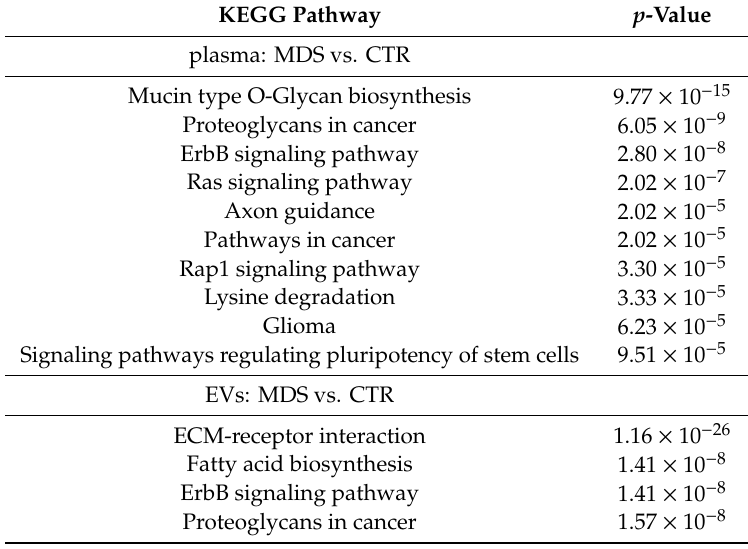
Table 1. The most significantly enriched pathways in the four di ff erent sets of deregulated miRNAs. The top ten pathways with the highest p -values are listed for each